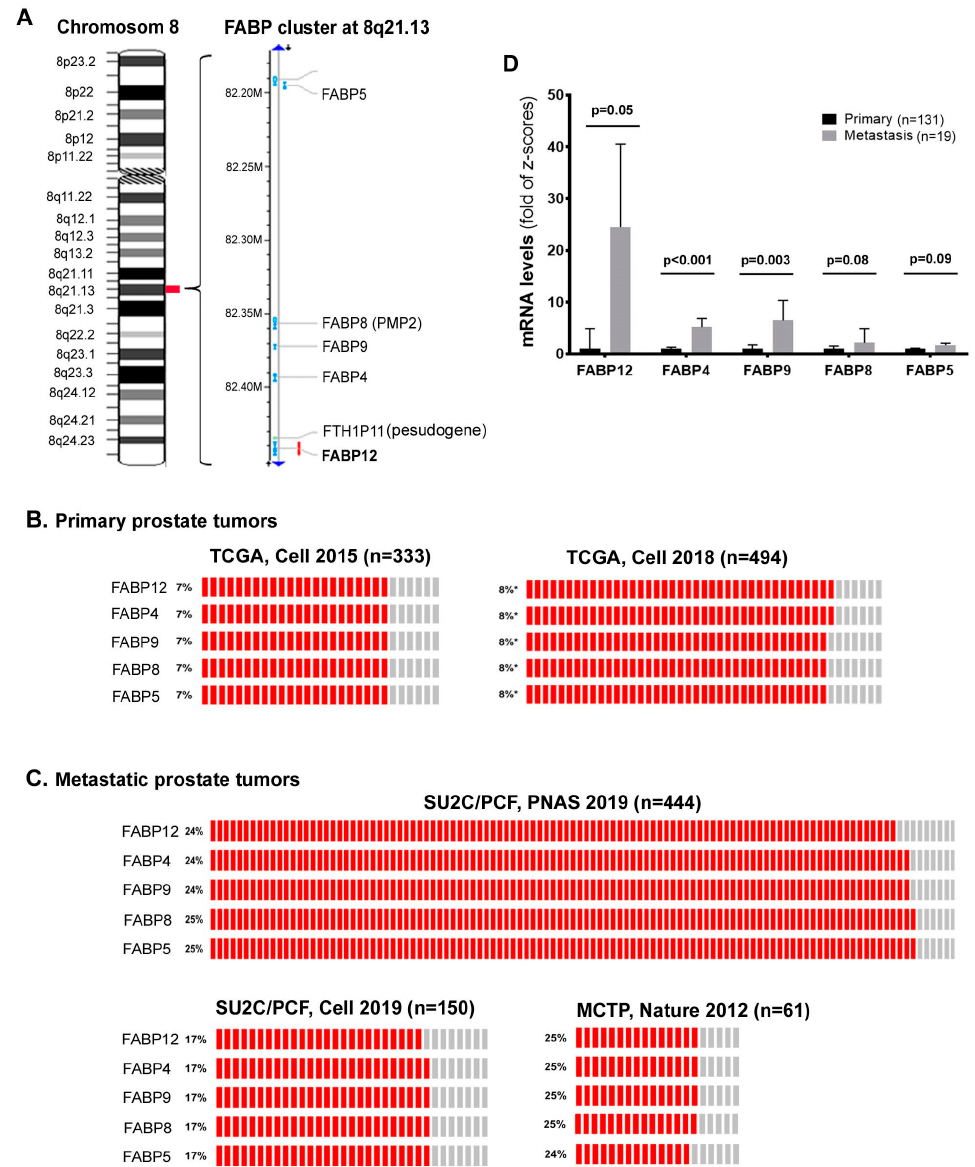
Figure 1. A fatty acid-binding protein (FABP) gene cluster at chromosome 8q21.13 is preferentially amplified in human metastatic prostate cancer (PCa). ( A ) Five FABP ( FABP12 , FABP4 , FABP9 , FABP8 and FABP5 ) genes are clustered on human chromosome 8 at 8q21.13. The left panel shows the chromosomal banding pattern of human chromosome 8 and the right panel provides physical distance between each FABP gene locus in millions of base pairs (M) of DNA. Chromosomal and gene mapping information was obtained from the NCBI (www.ncbi.nlm.nih.gov). ( B ) FABP gene amplification frequencies in tumor tissues from primary PCa cohorts. ( C ) FABP gene amplification frequencies in tumor tissues from metastatic PCa cohorts. ( D ) Comparison of mRNA levels for each FABP gene in the 8q21.13 amplicon between primary and metastatic PCa tissues. Analysis of FABP gene amplification and mRNA levels was carried out using human PCa patient datasets from cBioPortal (www.cbioportal.org). Error bars represent standard deviation. n denotes sample size; p , statistical significance level. Except for FABP5 , mRNA levels of FABP12 , FABP4 , FABP9 and FABP8 were upregulated in cancers with higher Gleason scores (Table 1). FABP4 and FABP9 mRNA levels were also correlated